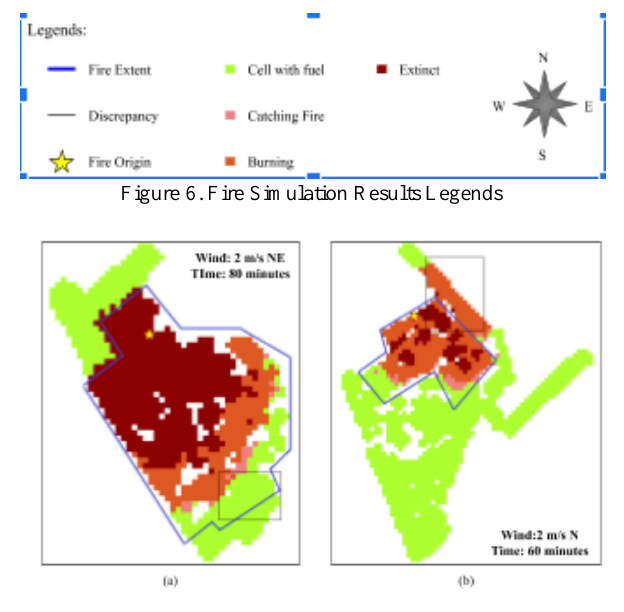
Figure 7. Simulation Results on Training Set, Tamiya (a) and